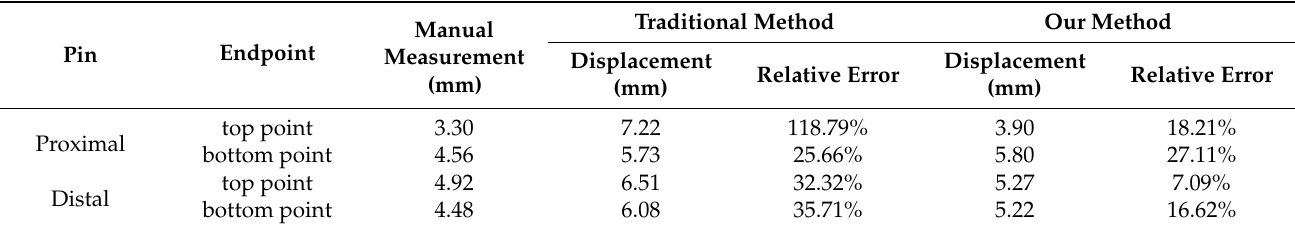
Table 9. Comparison results.